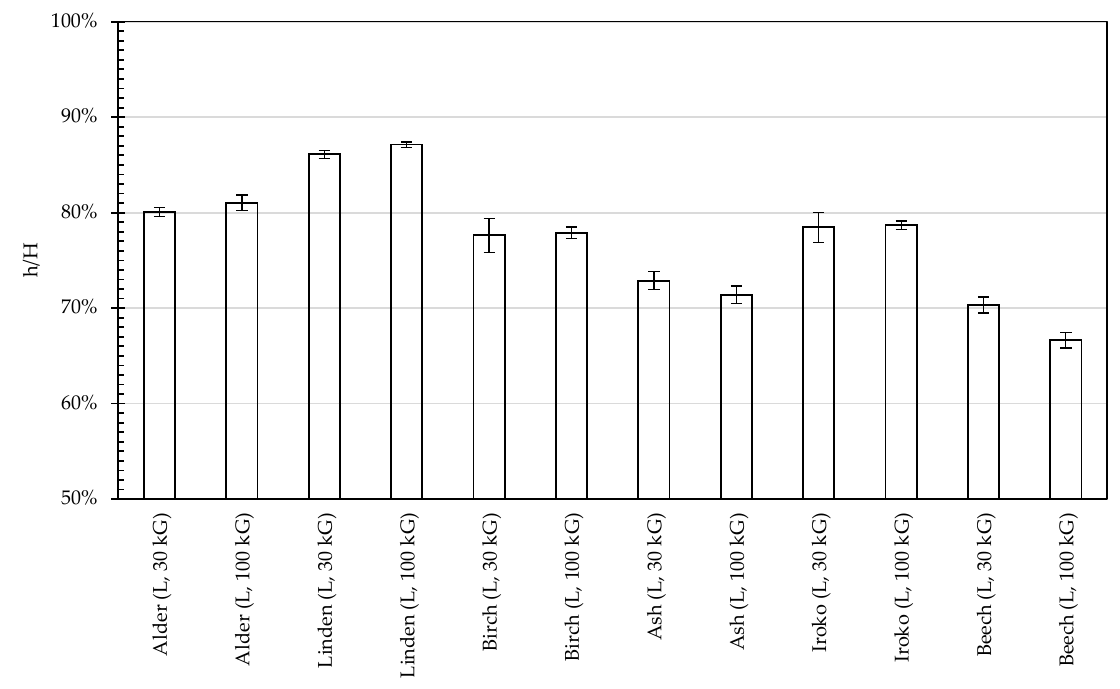
Figure 12. The L cross-section: the permanent imprint depth (h) shares of the total imprint depth ( H ). The imprint depths caused by the force of 30 kG (Figures 7–9) were from 2.1 to 3.0- times smaller than the imprint depth caused by the 100 kG measuring force. This propor- tion between the imprint depths was similar in all three main wood cross-sections (R, T, L). The depths of imprints in the R and T cross-sections were similar, while they were three-times greater than in the L cross-section.